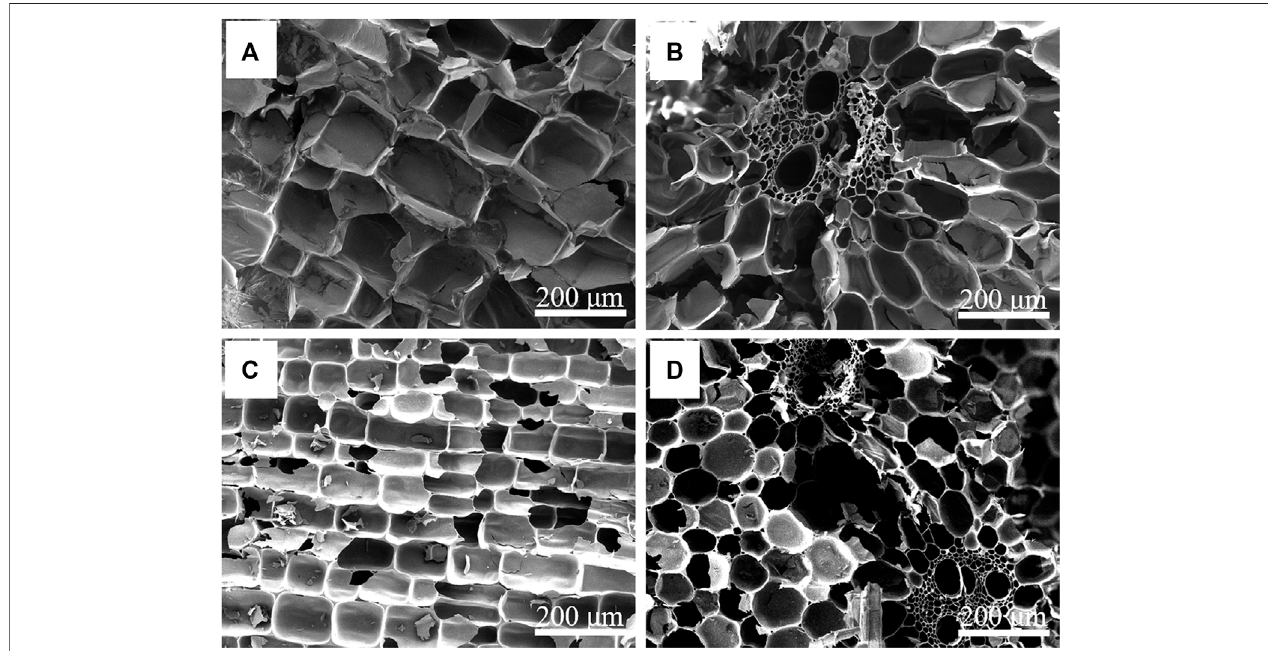
FIGURE 2 | SEM images of longitudinal-sectional and cross-sectional NC (A,B) and 310 (C,D) .